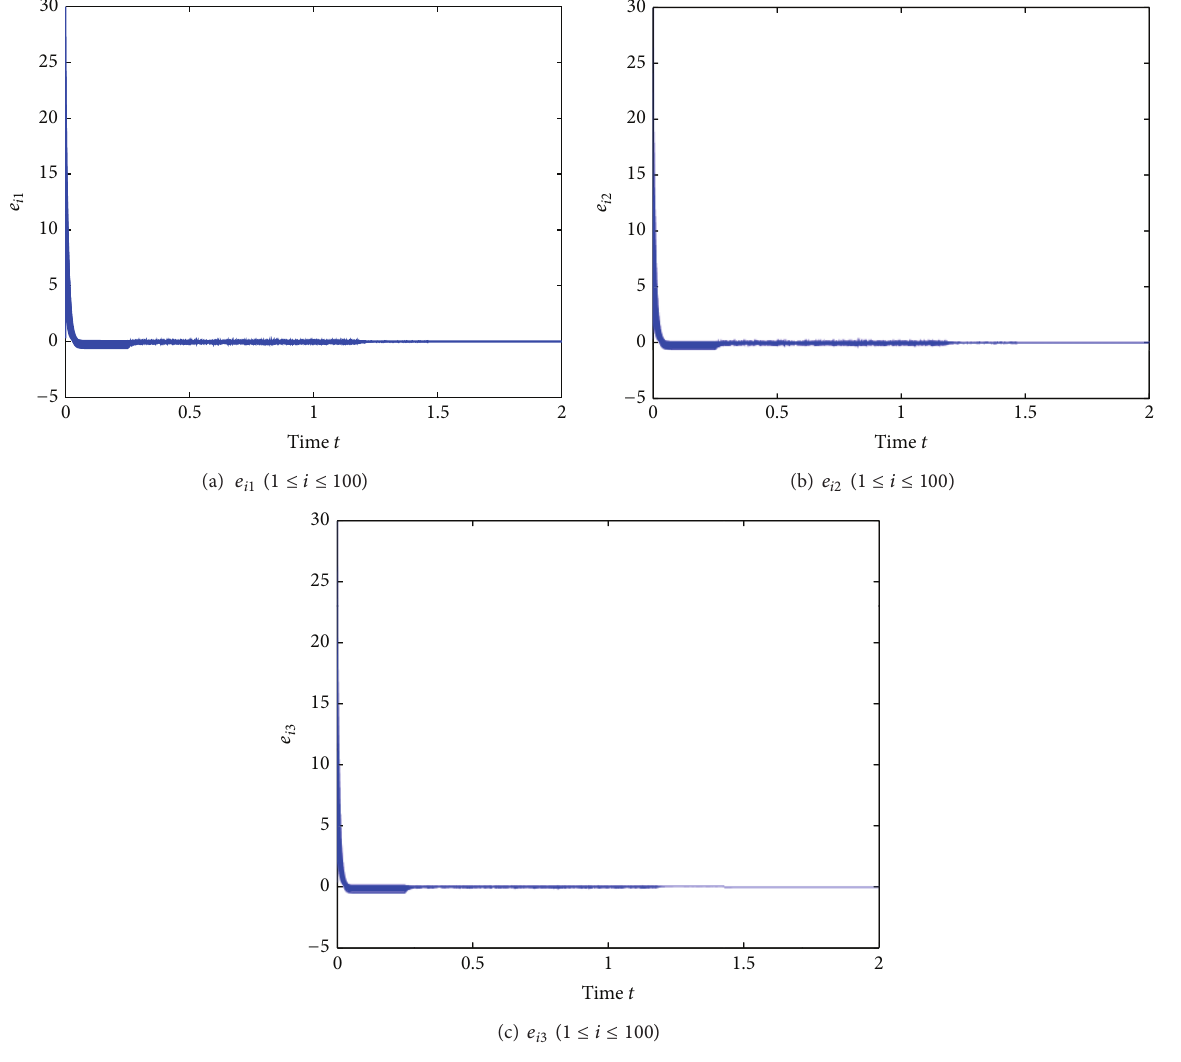
Figure 3: Synchronization errors 𝑒 𝑖𝑗 of the controlled network